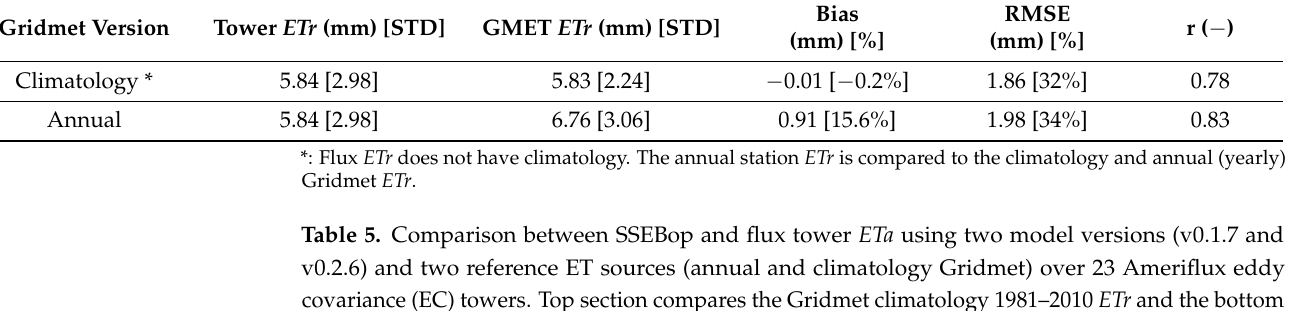
Table 5. Comparison between SSEBop and flux tower ETa using two model versions (v0.1.7